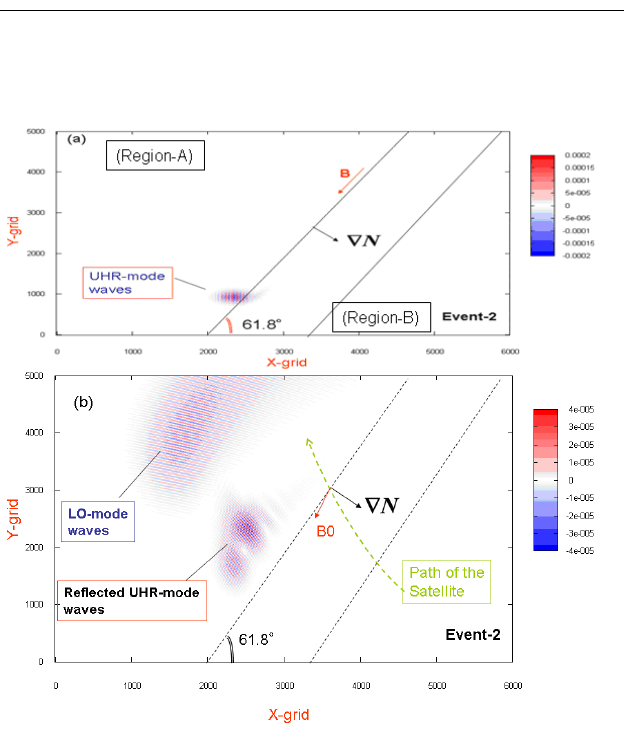
Fig. 7. Spatial distribution of the E x component of the electric field in the simulation system at (a) t =52.5 ω − 1 c and (b) t =172 ω − 1 c in